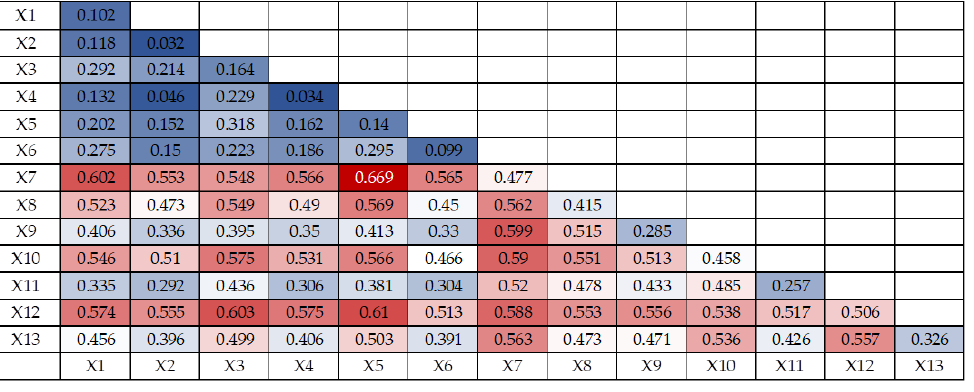
Figure 7. Ecological Vulnerability Interaction Detector Results in Shenyang in 2015.